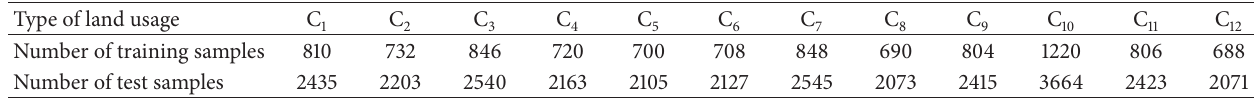
Table 2: All the samples extracted from the second zone.